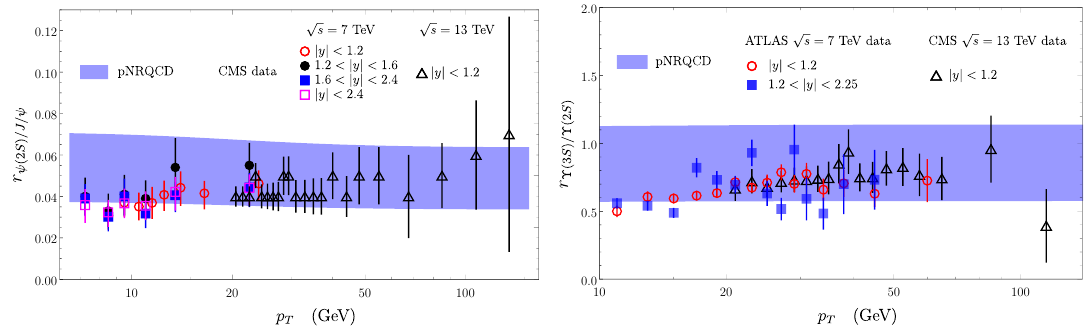
Figure 4 . Left: pNRQCD result for the ratio r defined in eq. (4.5) compared to CMS ψ (2 S ) /J/ψ √ √ data at center of mass energies s = 7 TeV [69] and s = 13 TeV [70]. Right: pNRQCD result for the ratio r defined in eq. (4.8) compared to the experimental values obtained from Υ(3 S ) / Υ(2 S ) √ measurements of r and r from ATLAS at s = 7 TeV [71] and from CMS at Υ(3 S ) / Υ(1 S ) Υ(2 S ) / Υ(1 S ) √ s = 13 TeV